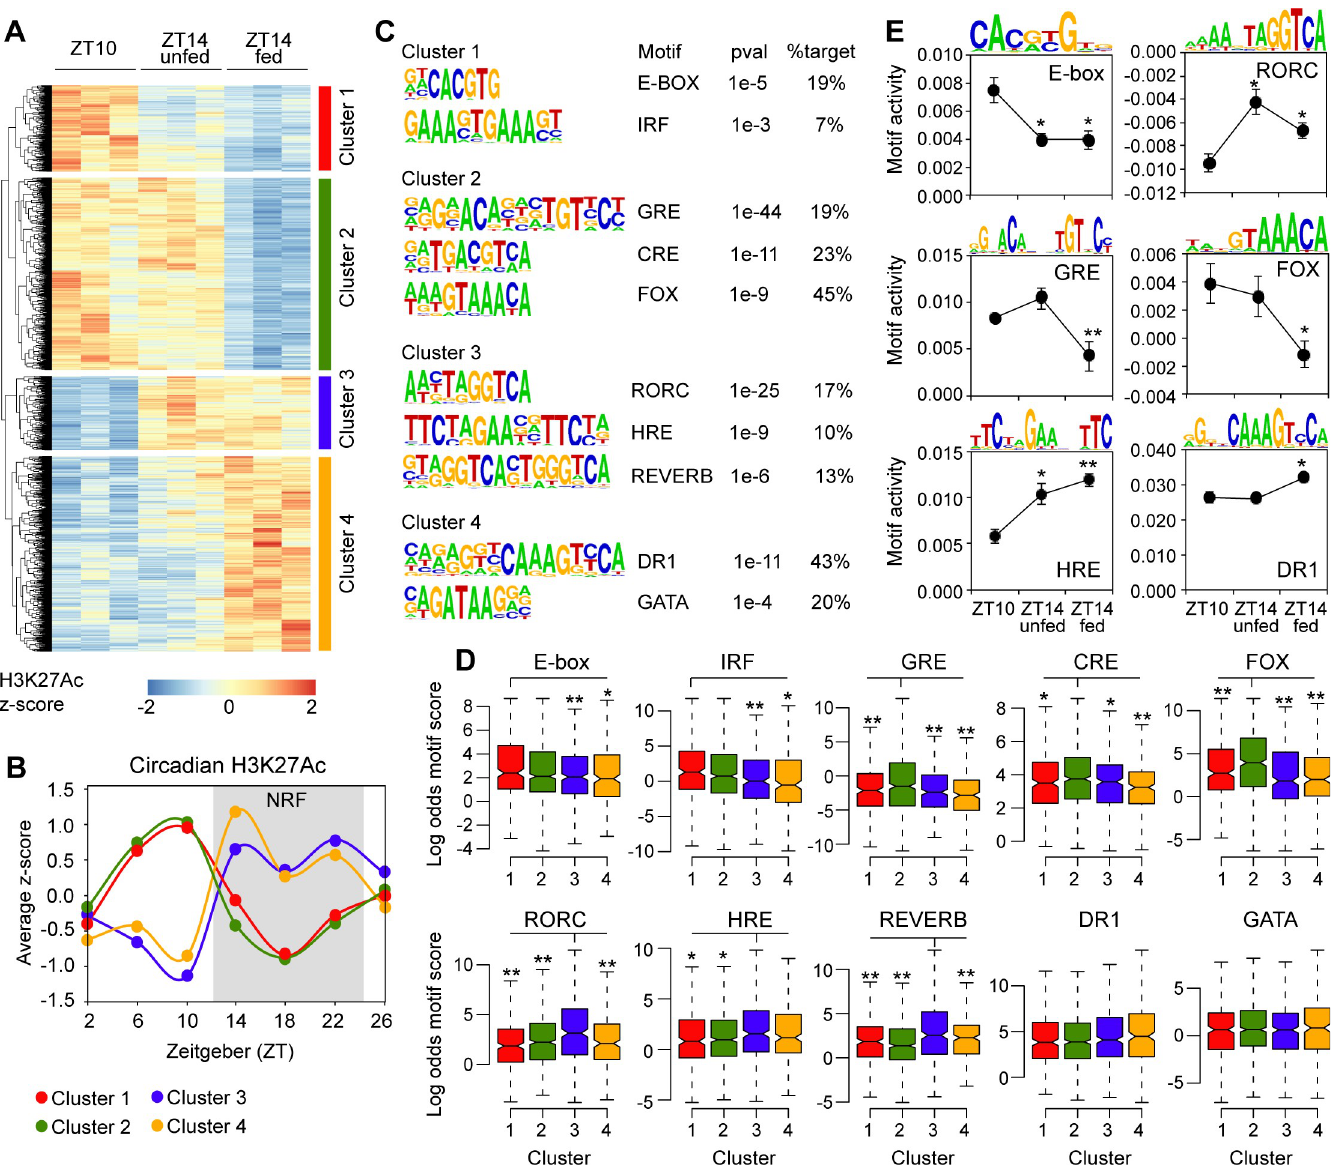
Fig 3. Enriched DNA motif analysis within DHSs associated with differentially regulated H3K27Ac. (A) DHSs differentially H3K27 acetylated at ZT14-fed compared to ZT10 was identified at FDR < 0.1 ( n = 3). At these DHSs, H3K27Ac was quantified in livers from three biological replicates at ZT10, ZT14-unfed, and ZT14-fed. H3K27Ac tag count is visualized as z-scores. Hierarchical clustering reveals four distinct clusters. (B) Circadian H3K27Ac of DHSs associated with clusters 1–4. Circadian H3K27Ac ChIP-seq data is from livers of NRF animals [16], and the tag count is normalized to a z-score. The average z-score for each cluster is plotted as a function of time. (C) DNA motif analysis of DHSs associated with clusters 1–4. (D) Quantification of the log odds motif score for each motif in DHSs associated with clusters 1–4. Statistical significance is calculated using Kruskal–Wallis test followed by a posthoc pairwise Mann–Whitney–Wilcoxon Test. The Kruskal–Wallis p -value is less than 0.05 between clusters for all motifs except DR-1 and GATA. (E) Activity of selected motifs calculated using IMAGE [26]. Data are presented as mean ± SEM ( n = 3). Statistical significance is calculated using Student t test. � p < 0.05 and �� p < 0.005. Numerical values for panels A, B, D, and E are available in S3 Data. DHS, DNase hypersensitive site; DR-1, direct repeat; FDR, false discovery rate; H3K27Ac, histone 3 lysine 27 acetylation; IMAGE, integrated analysis of motif activity and gene expression; NRF, night-restricted fed.